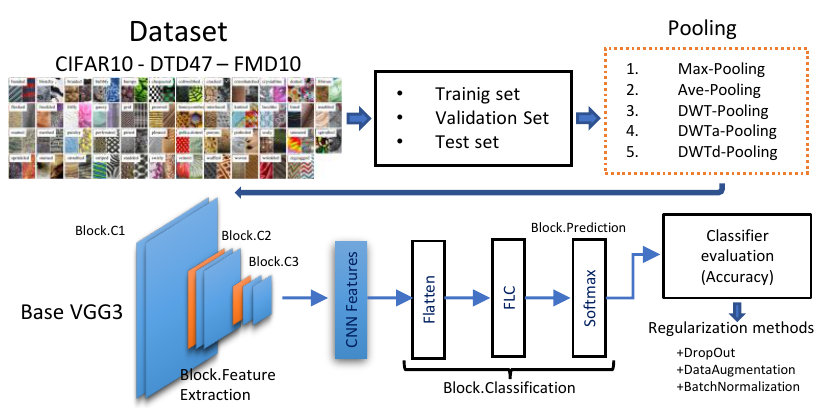
Figure 2. Block diagram for the proposed